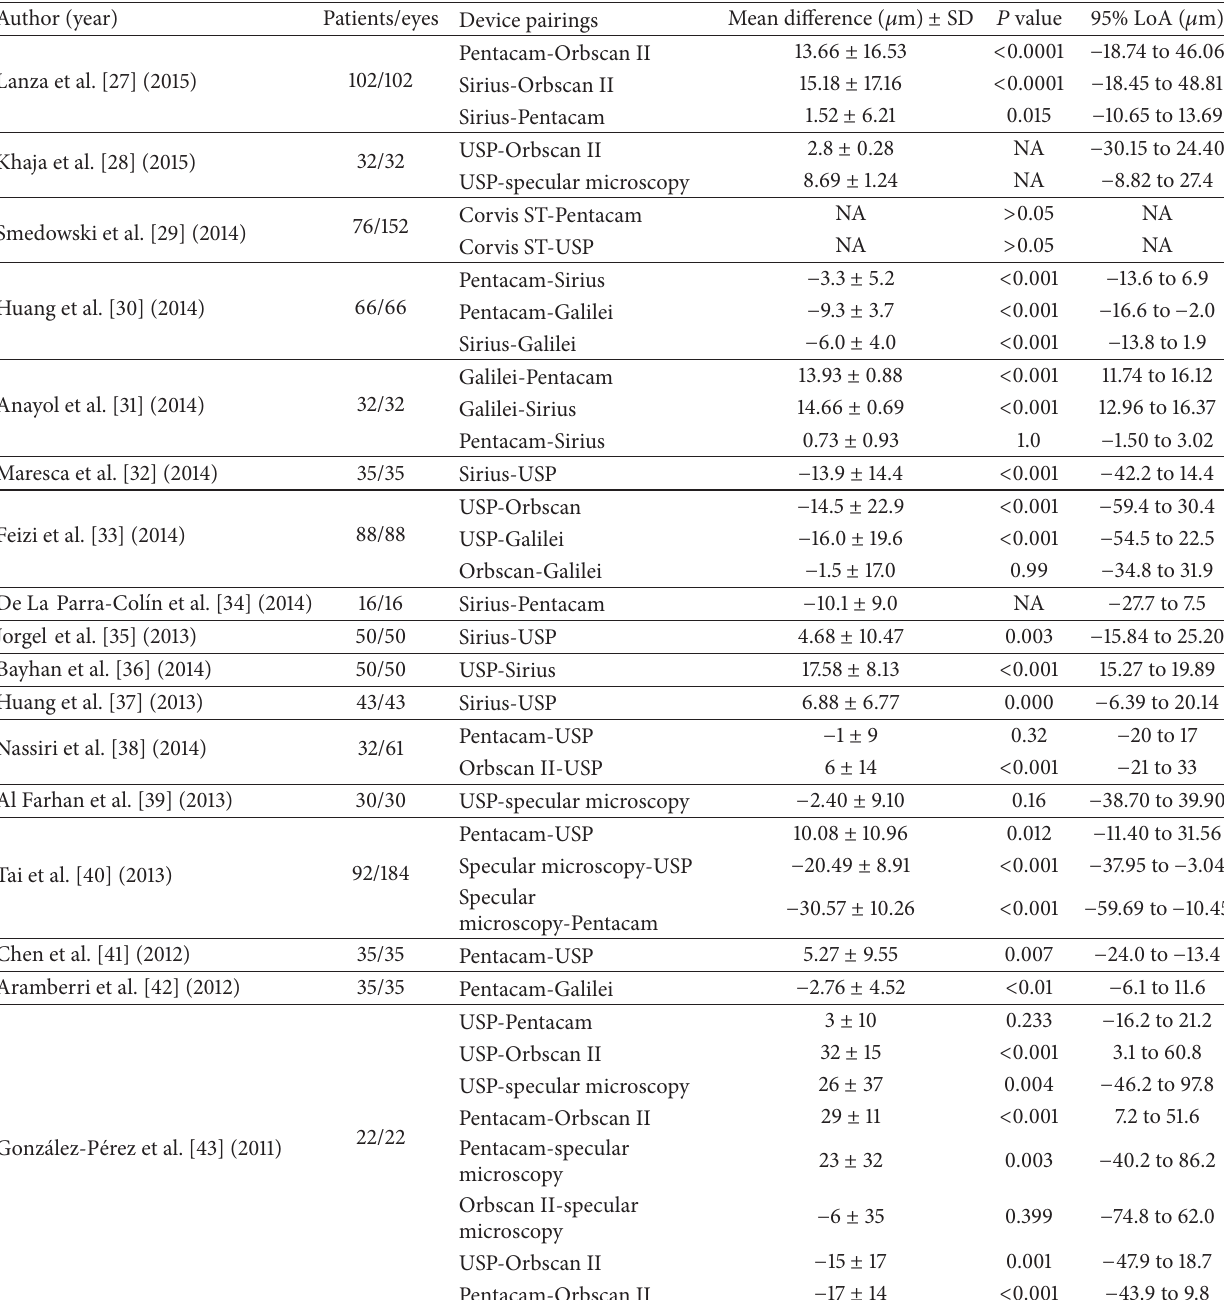
Table 4: Summary of previous studies for the agreement of CCT measurements obtained by other Scheimpflug systems, Orbscan II and specular microscopes in comparison to Pentacam or ultrasound